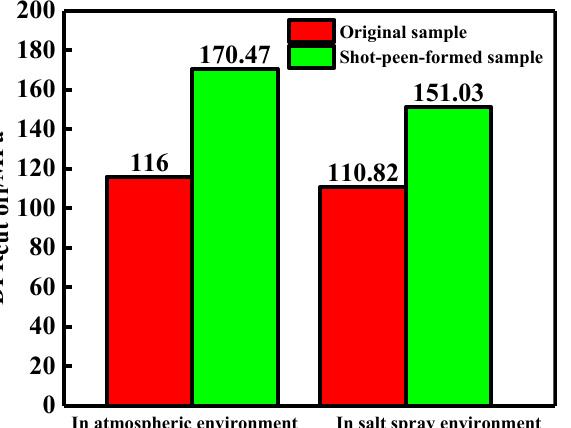
Figure 4. Effect of shot-peen forming on DFR value of the original and shot-peen-formed samples.